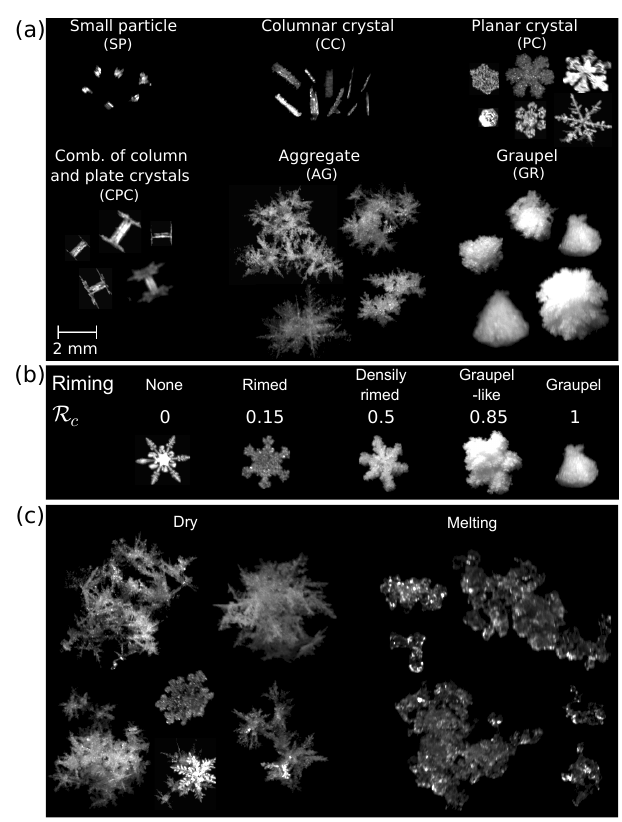
Figure 3. Examples of MASC particle images belonging to each hydrometeor class: (a) solid hydrometeor type, (b) riming scale and (c) detection of melting